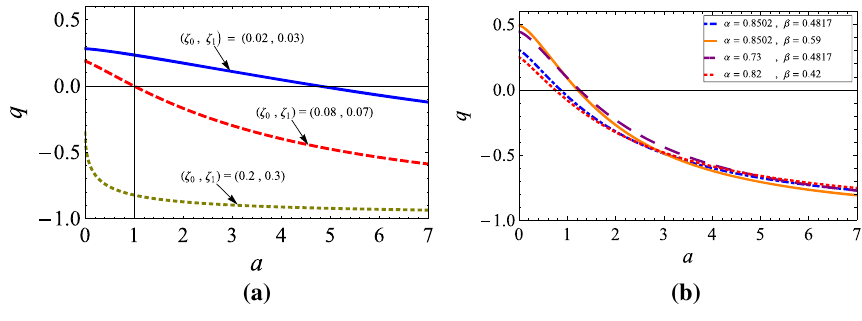
Fig. 7 a The q − a graph in q − a plane for different values of ζ 0 > 0 and ζ 1 > 0 with ω = − 0 . 5, α = 0 . 8502 and d β = 0 . 4817. b The q − a graph in q − a plane for different values of α and β with ζ 0 = 0 . 2, ζ = 0 . 3 and ω = − 0 . d 1